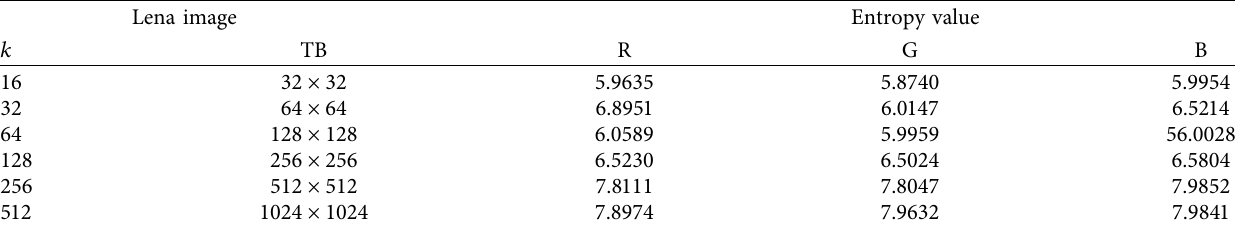
Table 2: Local entropy measures for different sizes of Lena